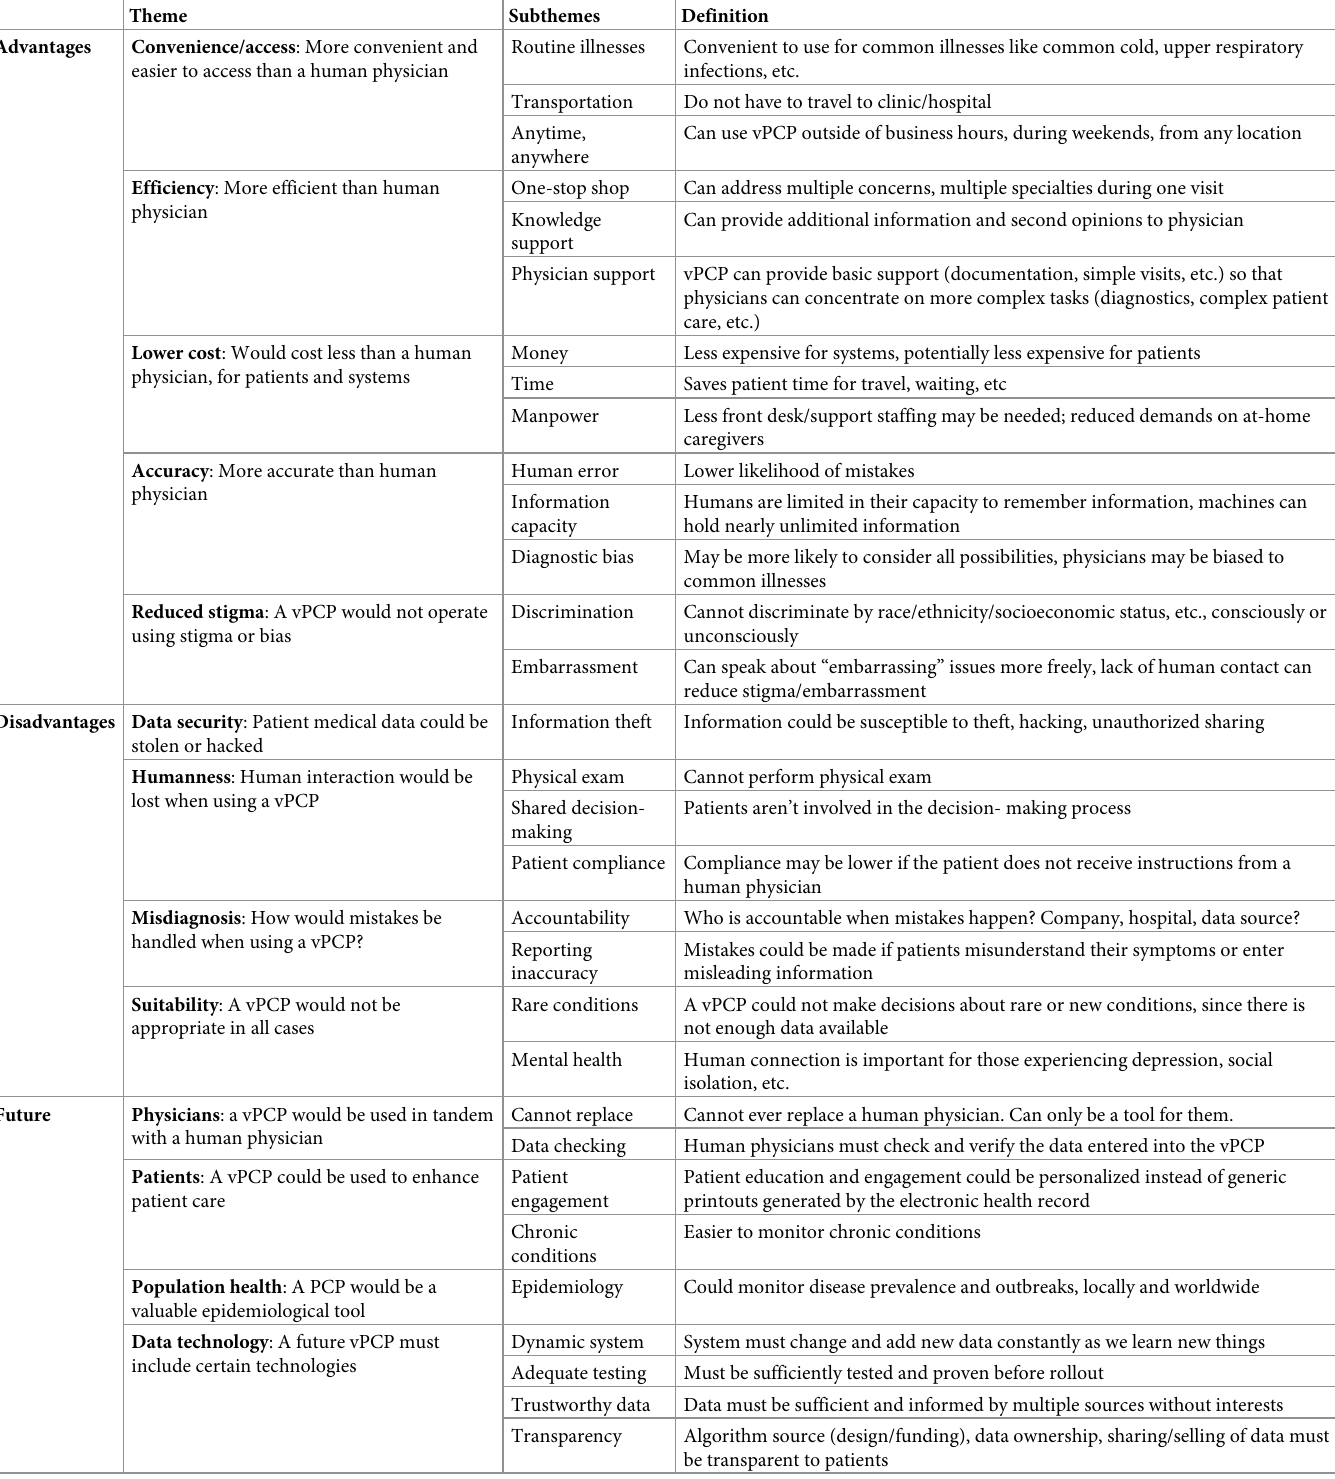
Table 1. Themes and subthemes of vPCP focus